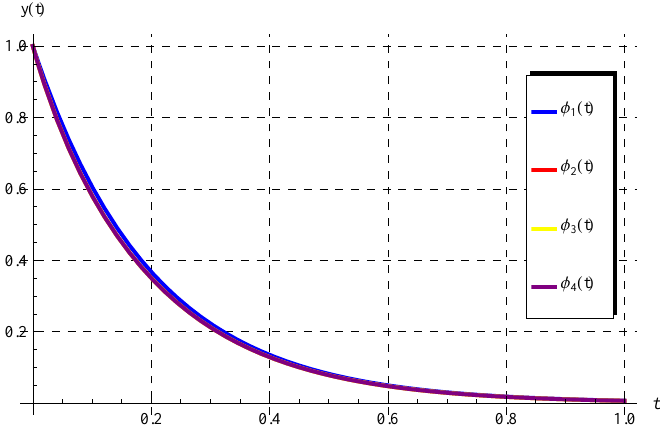
Figure 7. Plots of the approximate solutions φ m ( t ) , m = 3,4,5,6 in Equation (39) vs. t at λ = 1, c = 5 b = 3, and a = − 2.